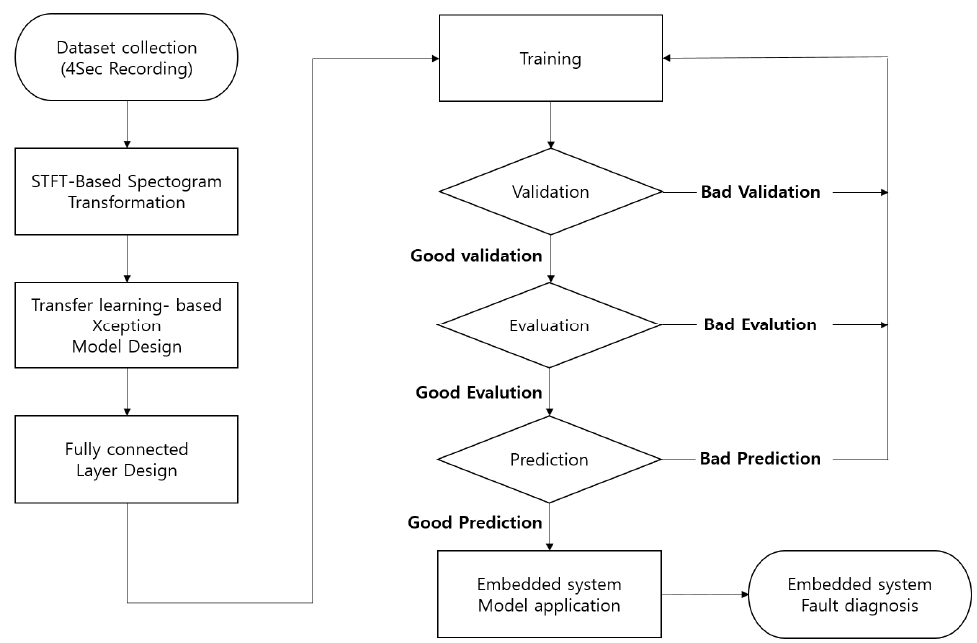
Figure 5. Development procedure of a fault diagnosis system using the CNN-based transfer learn- ing model.